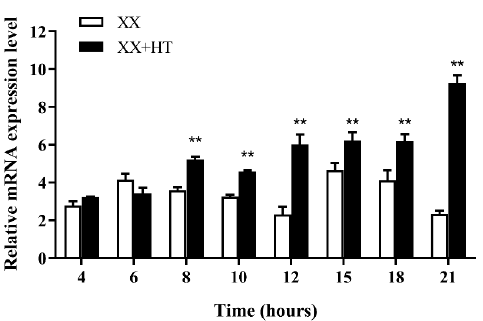
Figure 8. Chronological expression of Jarid2b in XX larvae brains within 21 h after high-temperature treatment. ** Statistically significantly difference ( p < 0.01).